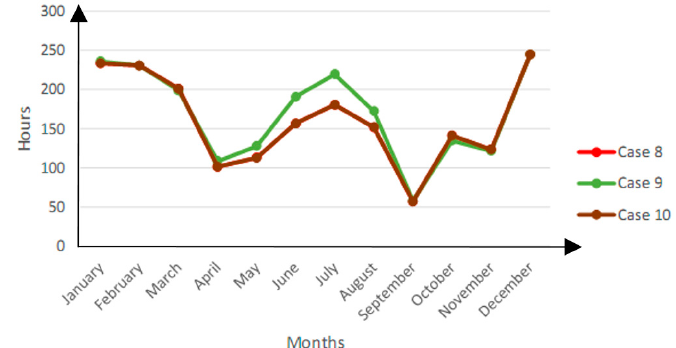
Figure 13. Discomfort hours for Cases 8, 9 and 10.